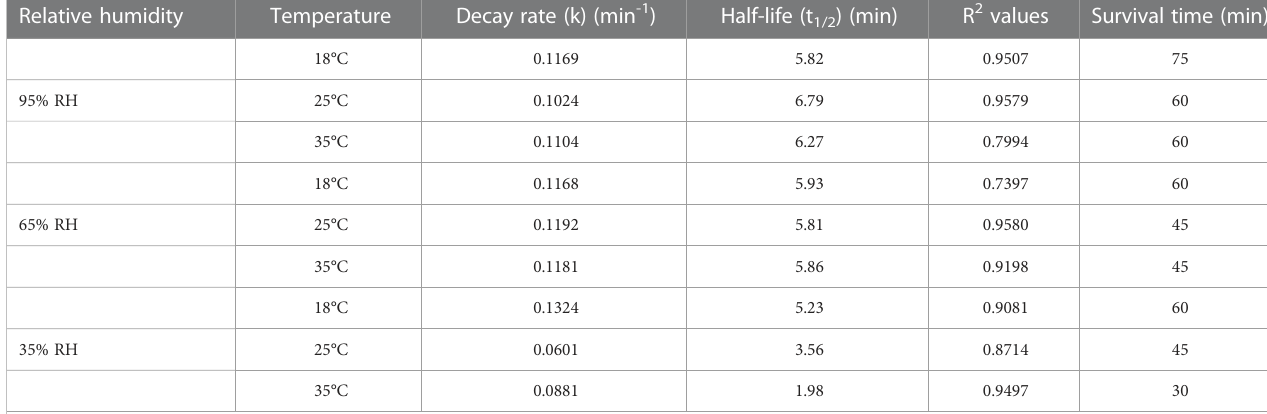
TABLE 1 Effect of temperature and relative humidity (RH) on Pseudomonas amygdali pv. lachrymans ( Pal ) survival in aerosols. Relative humidity